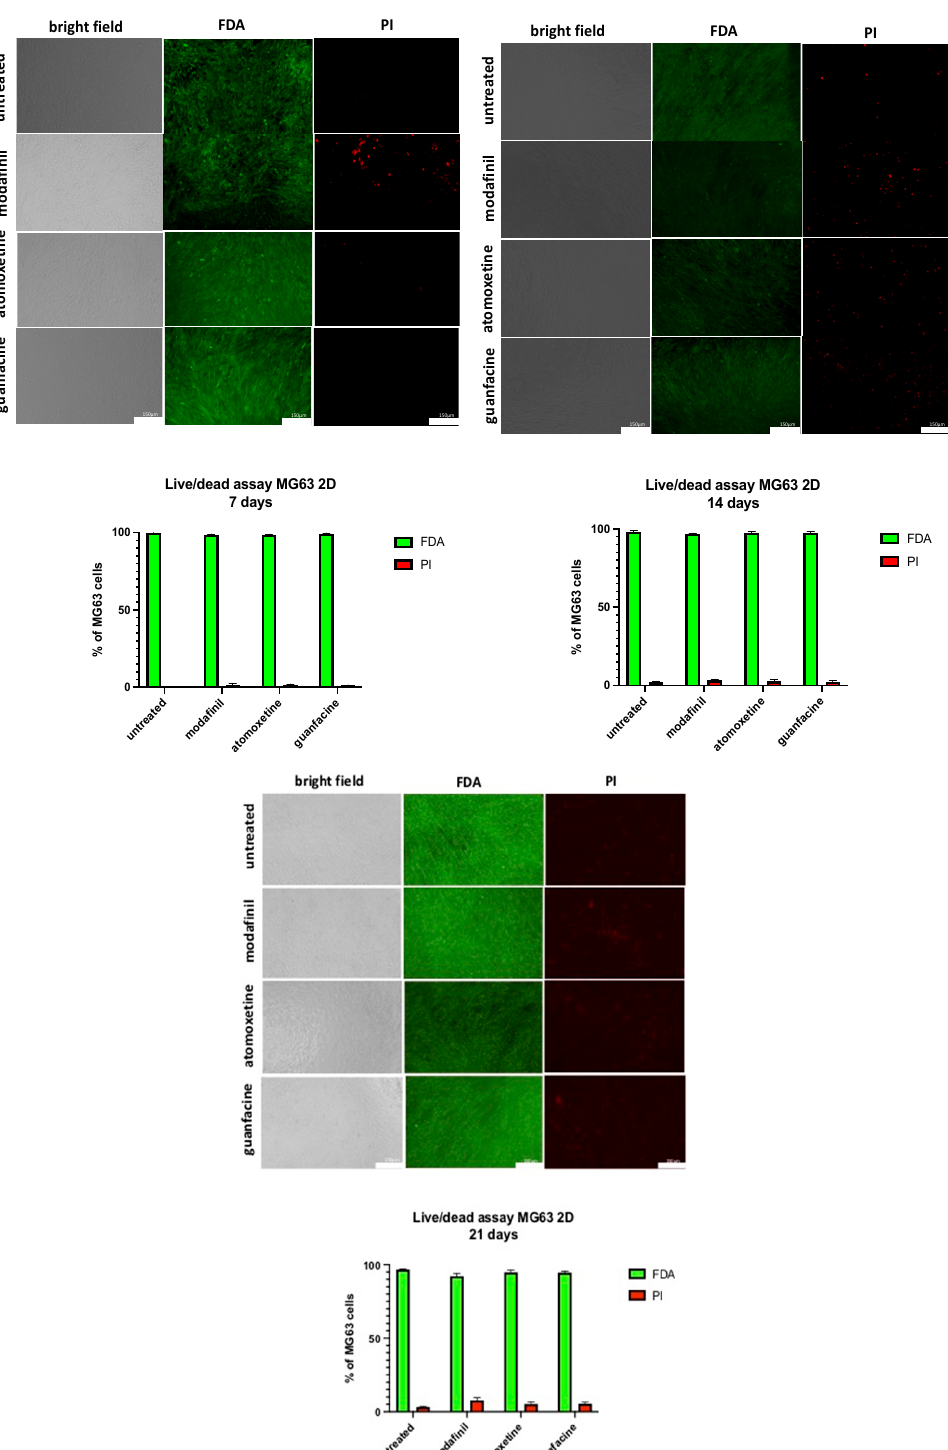
Figure 8. Cell viability assay of MG63-monolayer, using a live/dead staining with FDA. (green, live cells) and PI (red, dead cells). Images represent 7, 14 and 21-day-old monolayer MG63 of untreated, modafinil- (11.2 µg/mL), atomoxetine- (0.9 µg/mL) and guanfacine- (17.7 ng/mL) treated cells. Shown are three independent experiments with six biological replicates. Densitometric quantification of viable (green) and nonviable (red) cells was calculated by ImageJ software. Significance in difference between the groups was determined by ANOVA followed by Tukey’s post hoc test. Scale bar 150 µ